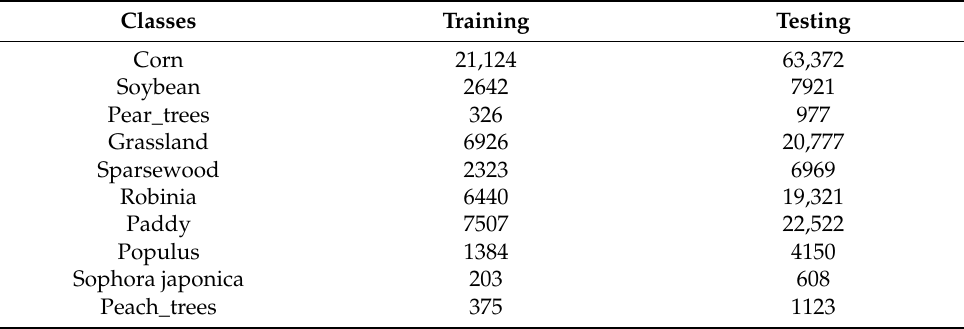
Table 3. Training and testing samples used in Xiong’an dataset.